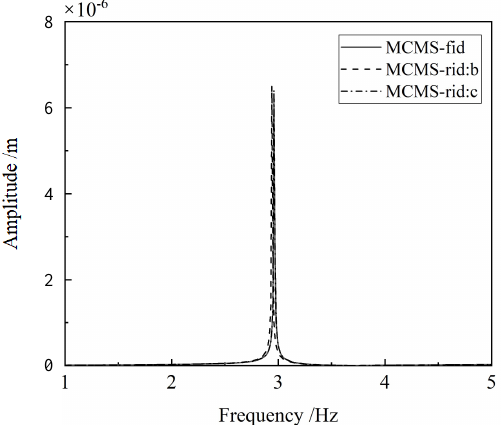
Figure 11. Frequency response functions of the beam by the FE model, MCMS-fid and MCMS-rids with different interpolation schemes for the first